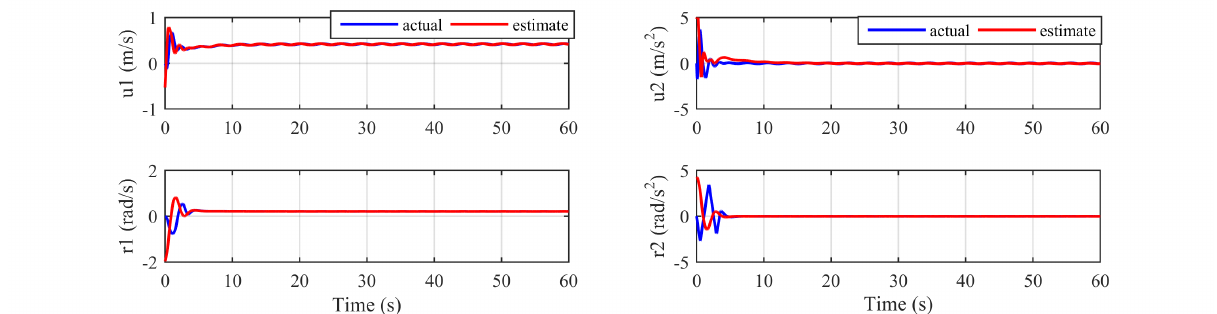
Figure 14. The estimations of u d , ˙ u d , r d , and ˙ r d based on fhan.